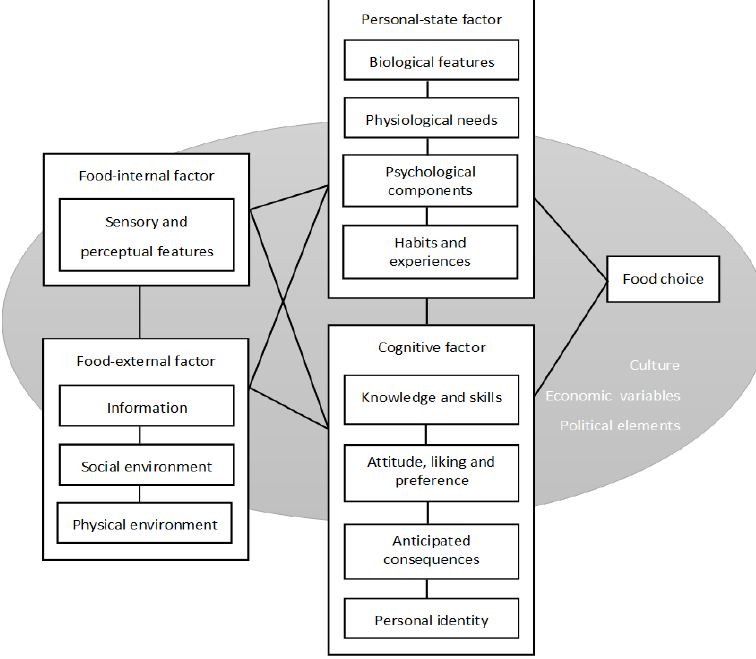
Figure 2. The proposed framework of factors influencing food choice developed from Eertmans et al. (2001)’s model [34]. The lines in the figure indicate the interactions between different factors. Table 1. Factors influencing individual food choice included in our proposed framework.